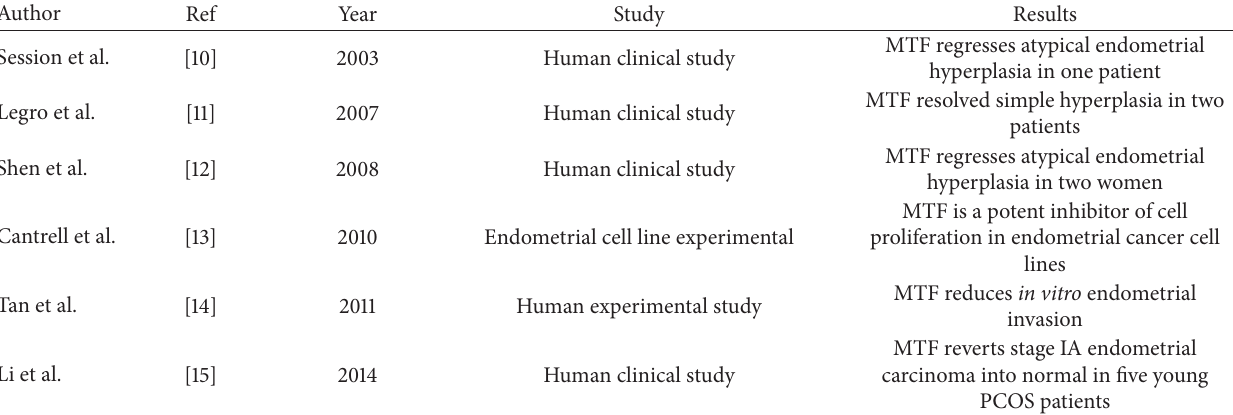
Table 1: Metformin and endometrial proliferative